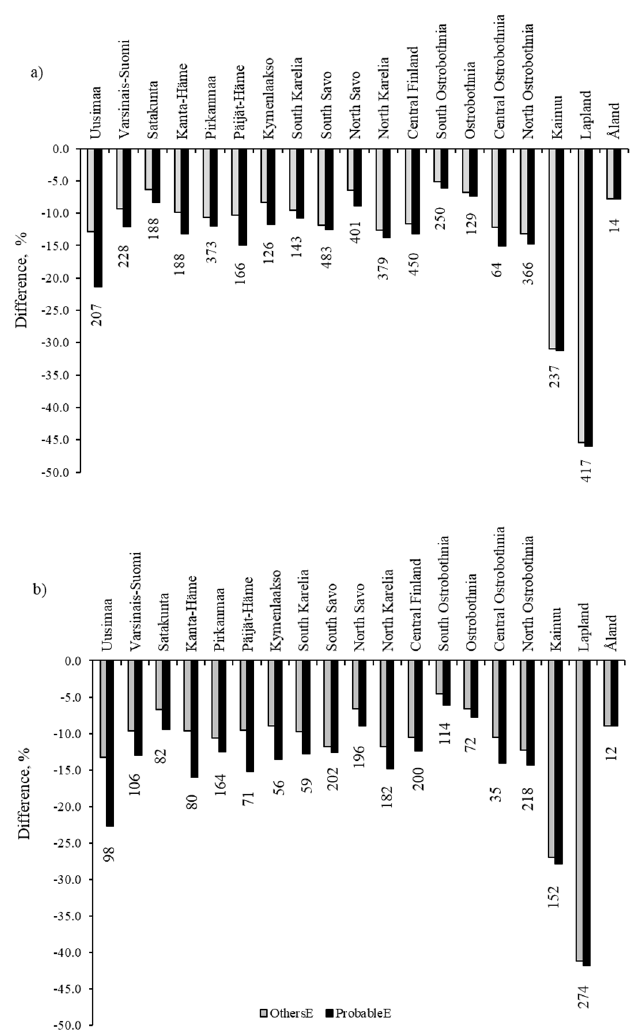
Figure 4. Difference (%) in ( a ) gross stumpage earnings and ( b ) logging costs in OthersE and ProbableE compared to the WRE scenario in different provinces in Finland. The numbers below the bars represent the gross stumpage earnings (million EUR year − 1 ) and logging costs (million EUR year − 1 ) in forest land in each province in the WRE in 2016–2025.